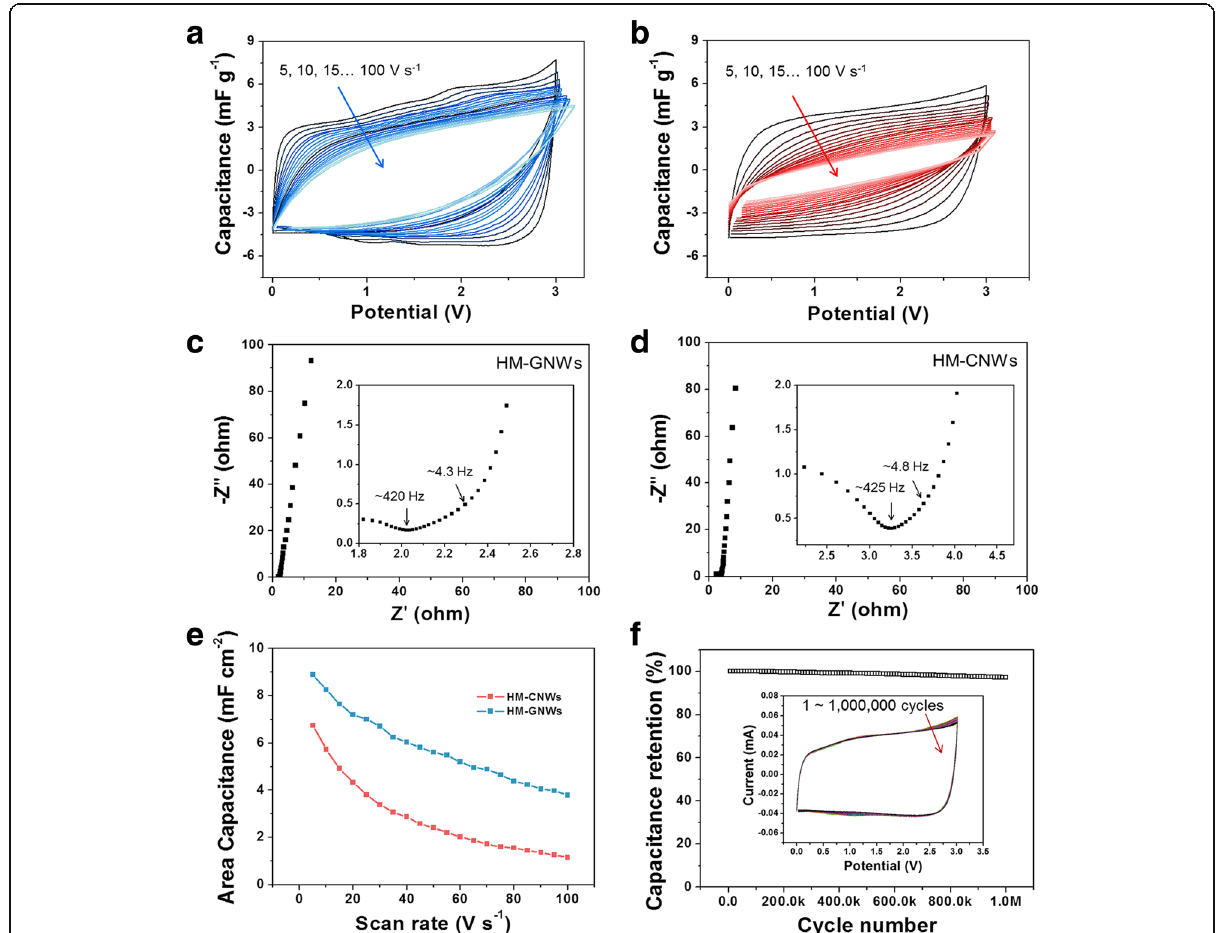
Fig. 3 Electrochemical performance of HM-CNWs and HM-GNWs in an EMIM PF 6 /ACN mixed (1:1 w / w ) solution over a voltage window of 0 – 3 V; CV curves at different sweep rates from 5 to 100 V s − 1 characterized every 5 V s − 1 of a HM-GNWs and b HM-CNWs. Nyquist plots of c HM-GNWs and d HM-CNWs (inset of the magnified images for the high frequency region). e Rate capabilities of both samples and f cycling performance of HM-GNWs (inset of the CV curves after long-term